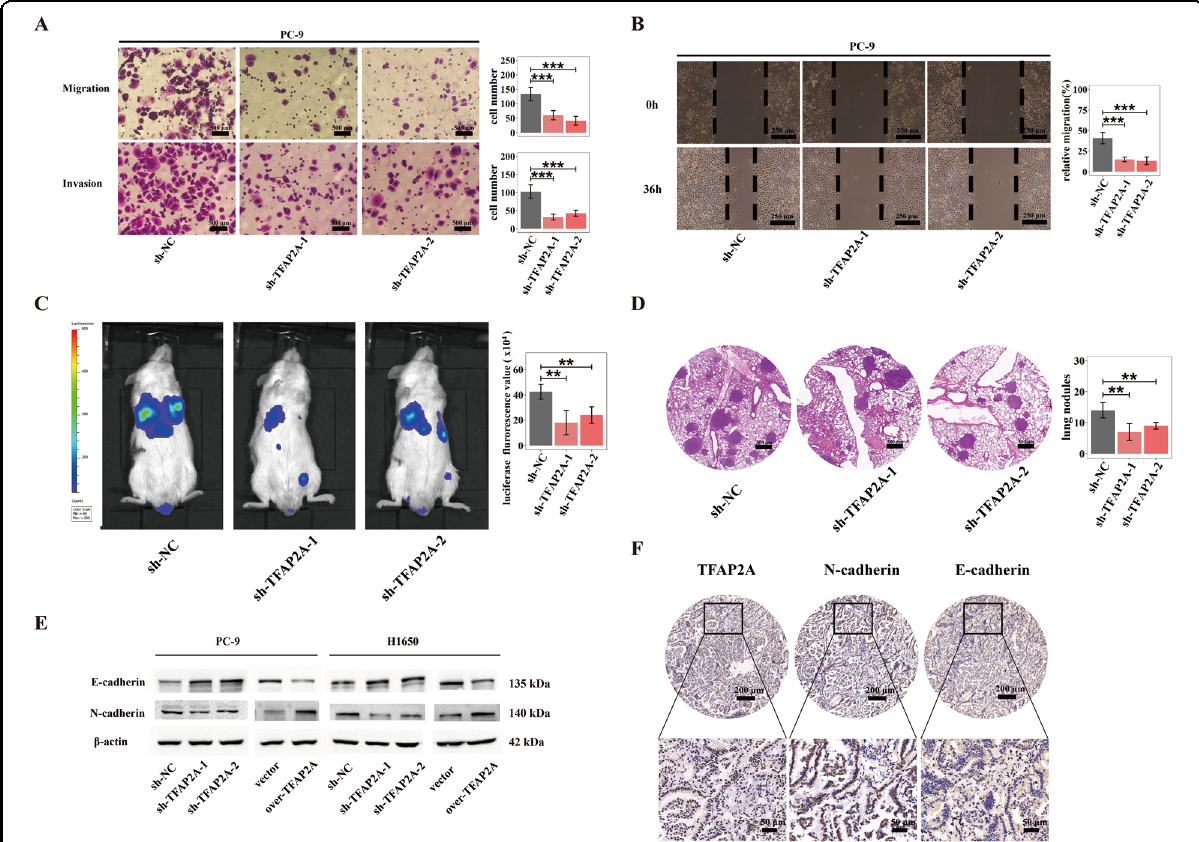
Fig. 4 TFAP2A could markedly potentiate LUAD metastasis possibly by promoting EMT. A Cell migratory and invasive ability (left) by transwell assay as well as statistical analysis (right) for TFAP2A knockdown cell models of PC-9. B Cell migratory ability via wound-healing assay (left) and statistical analysis (right) for TFAP2A knockdown cell models of PC-9. C Fluorescence intensity detected in mice (left) and statistical analysis (right) for evaluation of vivo metastasis ( fi ve mice in each group). D H&E staining (left) and statistical analysis (right) for metastatic nodules in dissected lung specimen from mice ( fi ve mice in each group). E E-cadherin and N-cadherin protein levels for TFAP2A knockdown and overexpression cell models of PC-9 and H1650 respectively. F IHC staining for protein levels of TFAP2A, N-cadherin and E-cadherin in clinical specimens of LUAD (up, low resolution; down, high resolution). * p < 0.05; ** p < 0.01; *** p < 0.001. N ≥ 3, Data are presented as mean ±